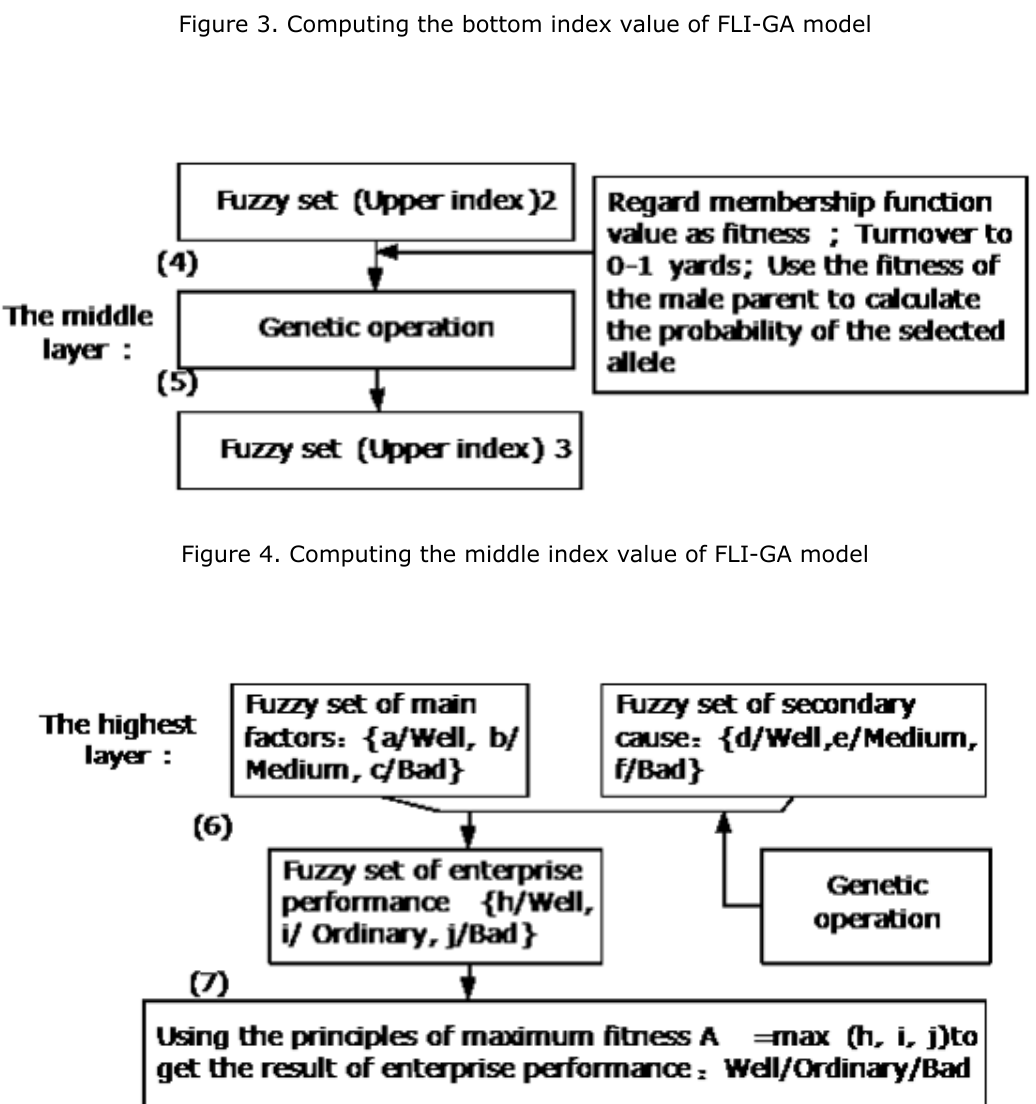
Figure 5. Computing the bottom index value of top tier